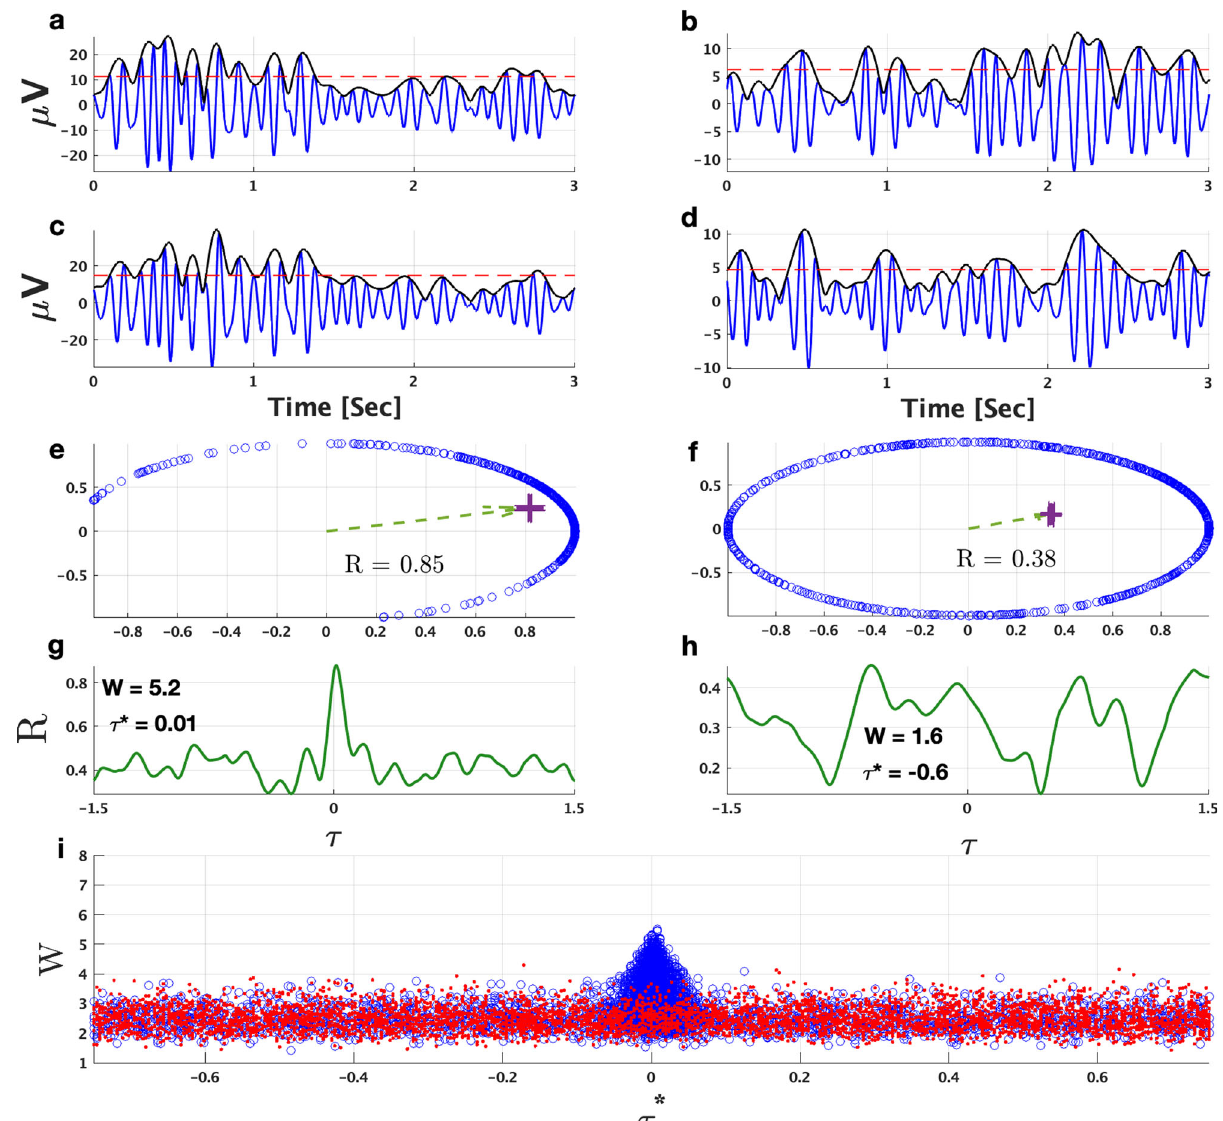
Fig. 6 Phase synchronization of amplitude-amplitude modulations and surrogate analysis to identify signi fi cant interactions. Two pairs of α frequency- band signals (blue curves in ( a ) − ( c ) and ( b ) − ( d )) from different EEG electrodes were obtained by applying a [7.8 − 15.59 Hz] bandpass- fi lter to the preprocessed EEG data. The black curves in each of these panels are the corresponding instantaneous amplitudes calculated by the analytic signal approach, Eq. (1). Red dashed lines are the corresponding averages h A j ð t Þi subtracted when applying the analytic signal approach to derive phases of these L instantaneous amplitudes. e Phase differences of the instantaneous amplitudes of ( a ) − ( c ) are clustered on the unit circle leading to a high synchronization index of R = 0.85 (Eq. (2)). In contrast, the signals in ( b ) − ( d ) are less synchronized as can be seen in ( f ), where the corresponding phase differences are distributed on the unit circle yielding a low index of R = 0.38. g , h Phase synchronization index R as a function of the shift τ between the instantaneous amplitude signals ( a ) vs. ( c ) and ( b ) vs. ( d ), respectively. The phase synchronized amplitude signals from ( a ) and ( c ) yield a maximum R at shift τ (cid:4) ¼ τ j ¼ 0, and R ( τ ) decays rapidly for ∣ τ ∣ > 0. For the much lower synchronized signals from ( b ) and ( d ), however, R ( τ ) shows fl uctuating R ð τ Þ(cid:5) R max behavior without clear decay. A signi fi cance value W characterizes R ( τ ) by normalizing R max by the mean and standard deviation of R ( τ ) (Eq. (3)). Correspondingly, we obtain a higher W value for panel ( g ) ( W = 5.2) than for panel ( h ) ( W = 1.6). We utilize W to characterize the signi fi cance of the interaction between two signals. Panel ( i ) indicates that the highest W values are observed for τ * ≈ 0. In this scatter plot we show 1000 α − α samples of W vs. τ * for real data (blue circles) and surrogate data (red dots). Real signals are taken from the same patient (using different EEG electrodes), whereas surrogate pairs were chosen randomly from different patients. Clearly, higher W values are obtained for real signals for τ * ≈ 0. The surrogate analysis does not lead to high W values around τ * ≈ 0 and shows a uniform W vs. τ * will have values closer to 1 (cp. Fig. 6e, f). We calculate the synchronization index R between signals of the same frequency stemming from different EEG electrodes. In general, R will be small (closer to 0) if the two amplitude signals are not Probing signi fi cant interactions in amplitude synchronization . In order to phase-synchronized, i.e., their phase differences are random and their complex exponentials do not show clustering on the unit circle. In case of a consistent phase distinguish signi fi cant from non-signi fi cant interactions between signals j 1 and j 2 , synchronization of the signals ’ amplitudes ( “ amplitude cross-modulation ” 41 ), R we study how their amplitude-phase synchronization index R decays when shifting